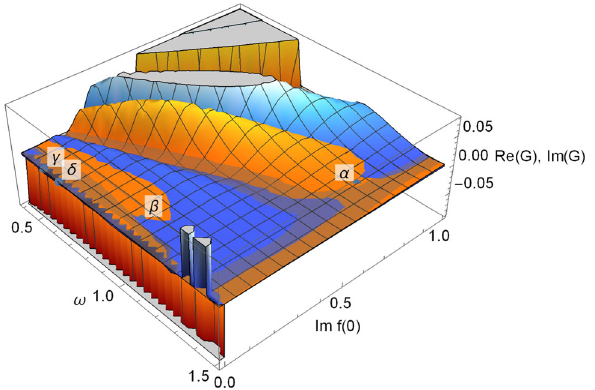
Fig. 9 Three-dimensional plot of the solution for the hyperbolic class in four dimensions. The real part of the constraint G (ω, Im f ( 0 )) is plotted in orange, the imaginary part in blue. The vanishing plane Re ( G ), Im ( G ) is shown in gray. The solutions lie at the intersection of these three surfaces